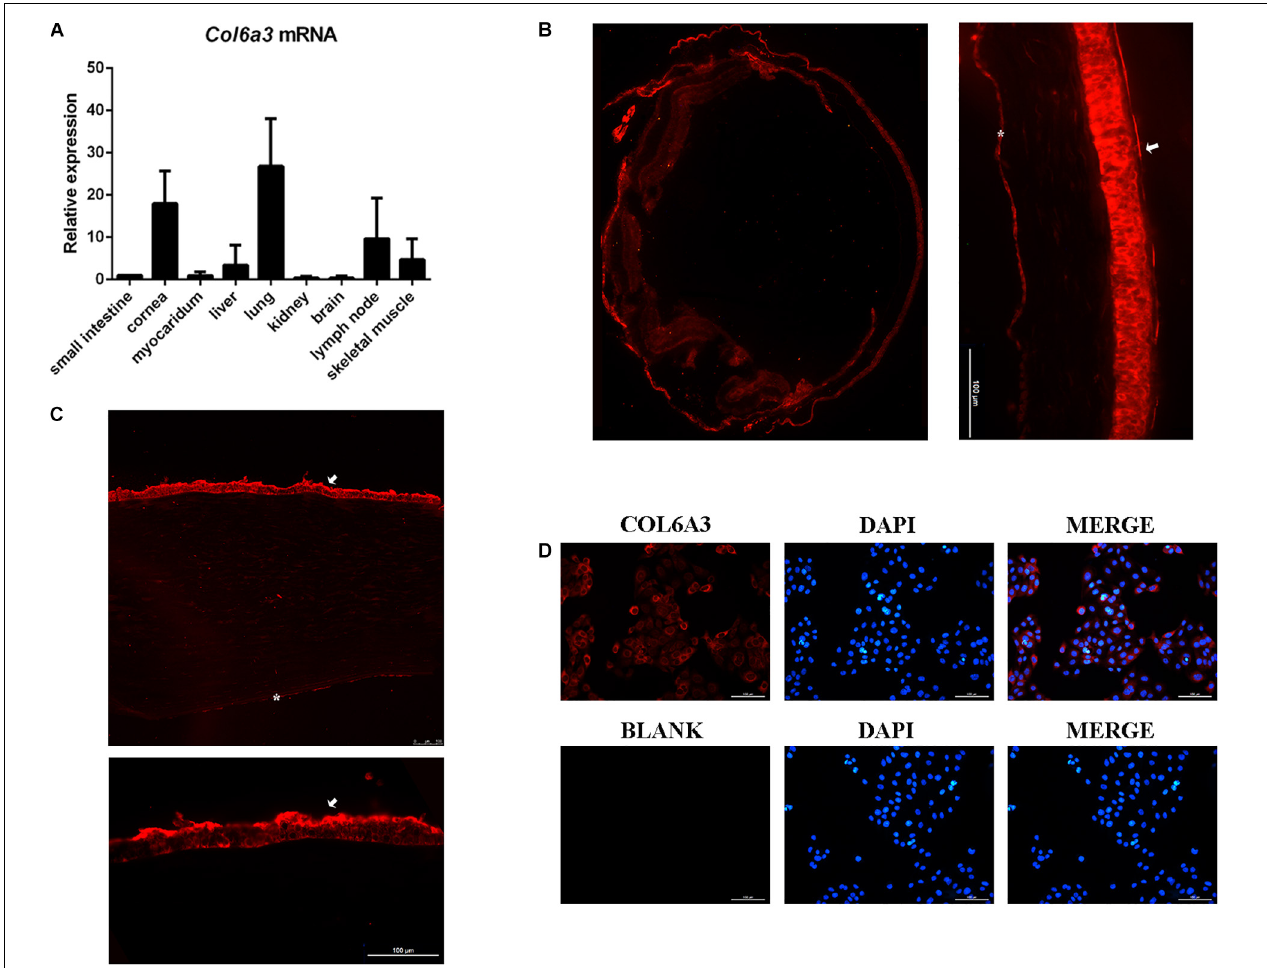
FIGURE 2 | Relatively high expression of COL6A3 in the cornea. (A) Expression profiles of Col6a3 mRNA in various murine tissues, as determined by RT-qPCR. Immunofluorescence images of COL6A3 protein distribution (red) in the mouse eye (B) and human cornea (C) . White arrows indicate the corneal epithelium, while the white asterisks indicate the corneal endothelium. (D) Immunofluorescence staining of the COL6A3 protein (red) in a human corneal epithelial cell line; nuclear DNA was counterstained with DAPI